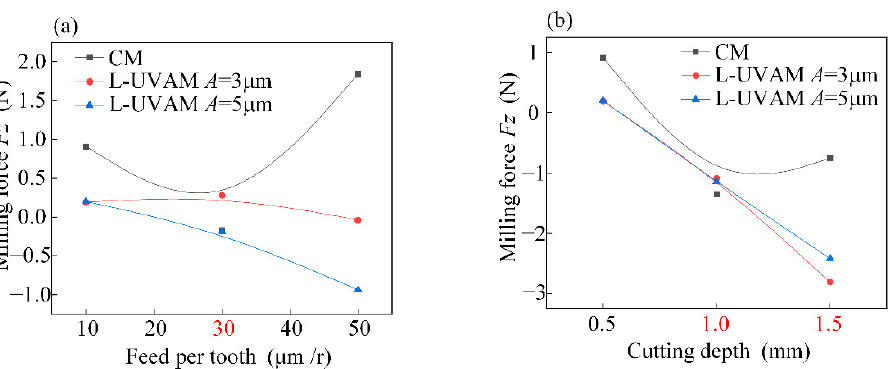
Figure 6. Single-factor analysis of Fy. ( a ) Effect of variation of feed per tooth on milling force Fy ; ( b ) Effect of cutting depth variation on milling force Fy.